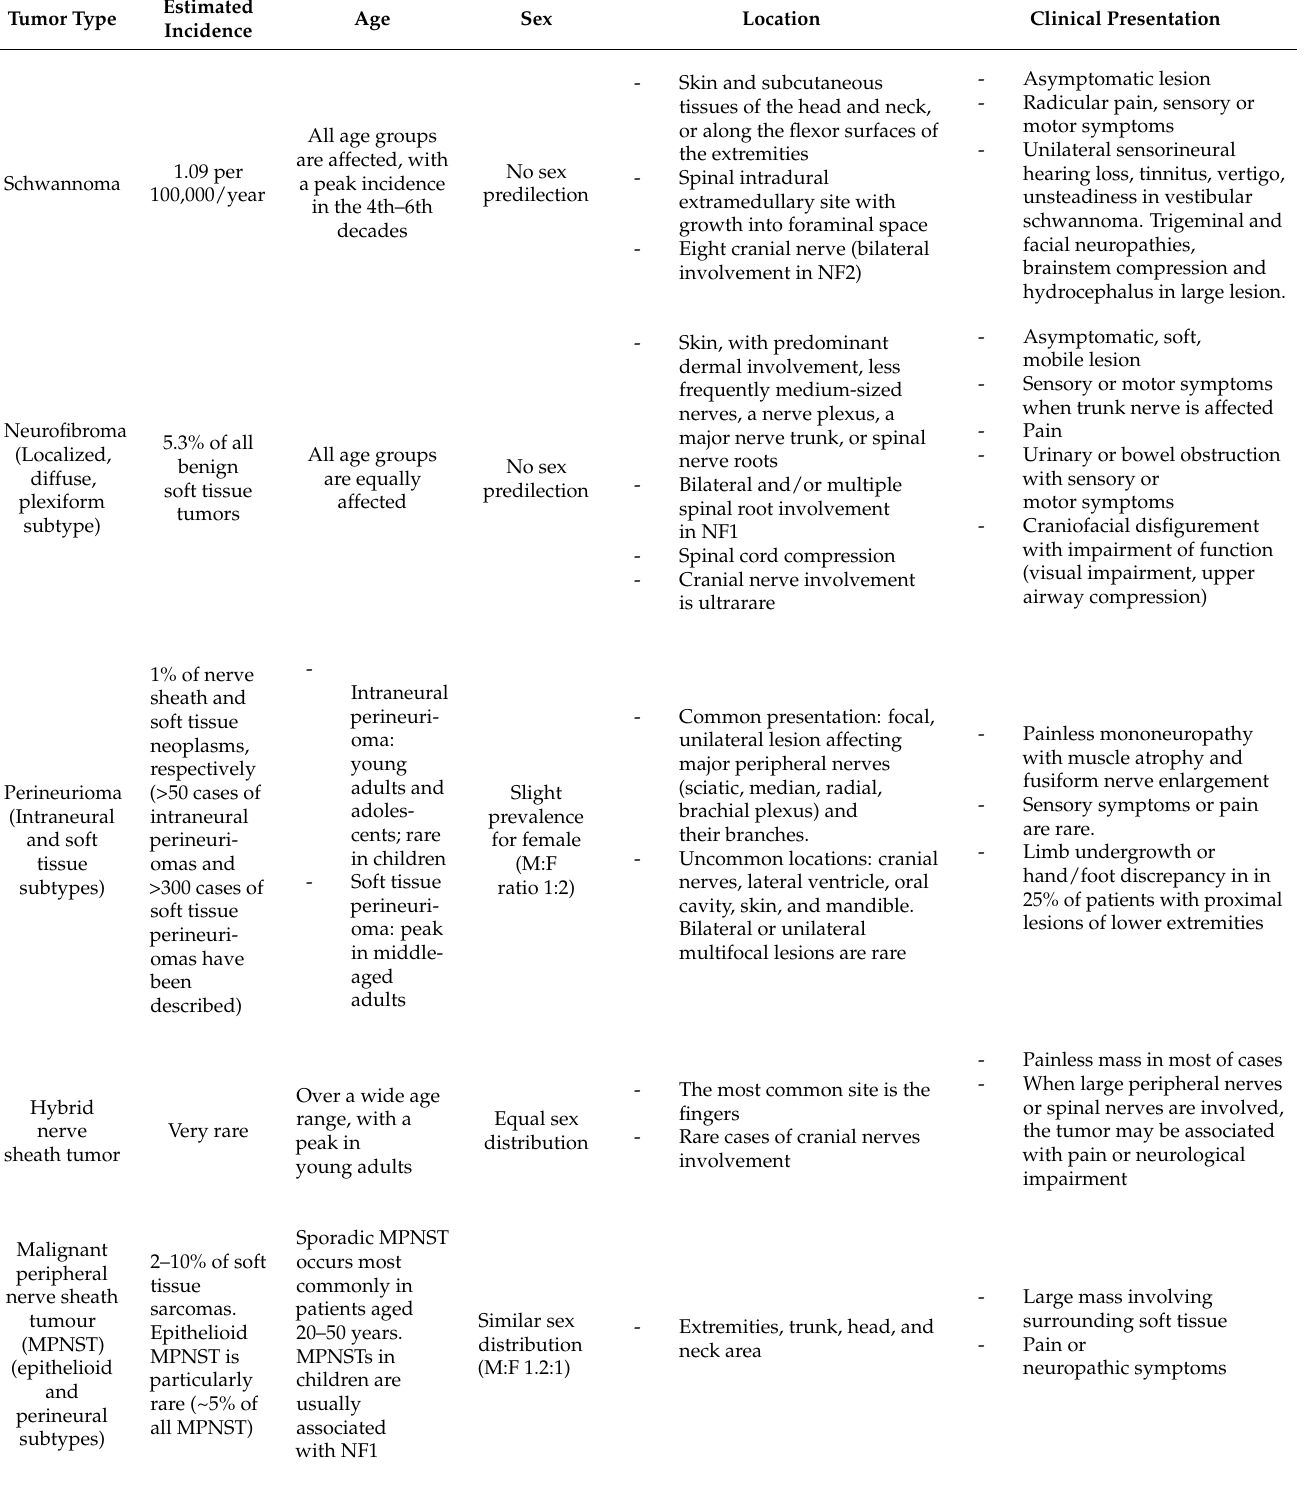
Table 1. Epidemiology and clinical